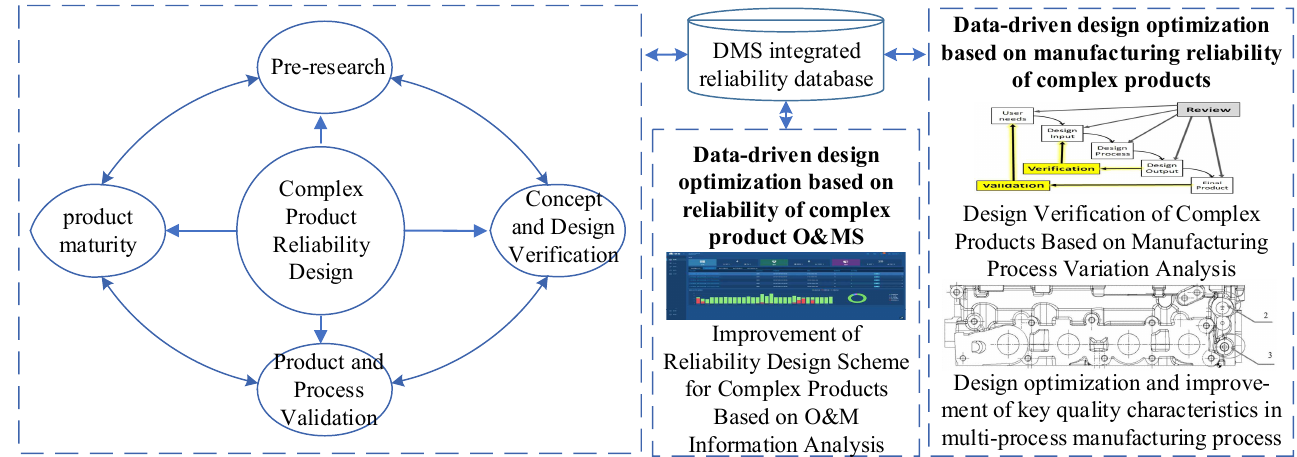
Figure 6. Research on reliability design optimization of complex products based on integrated reli- ability data of design and manufacturing services. reliability data of design and manufacturing